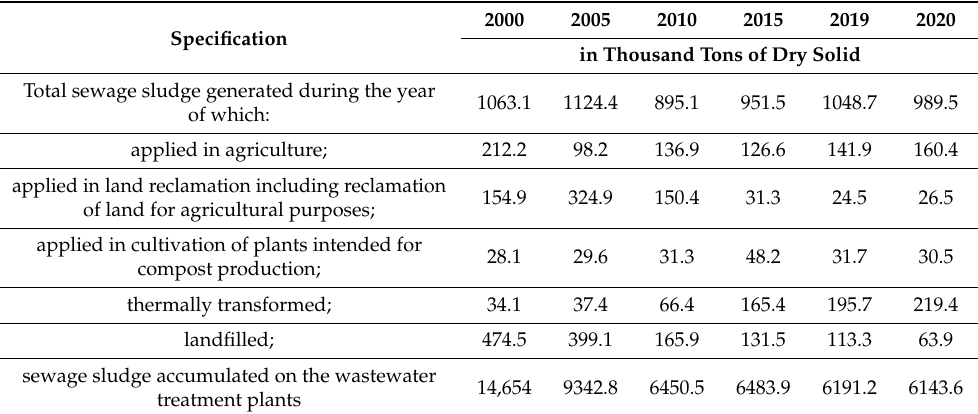
Table 1. Total production of sewage sludge from industrial and municipal wastewater treatment plants and trends in their use over the last 20 years